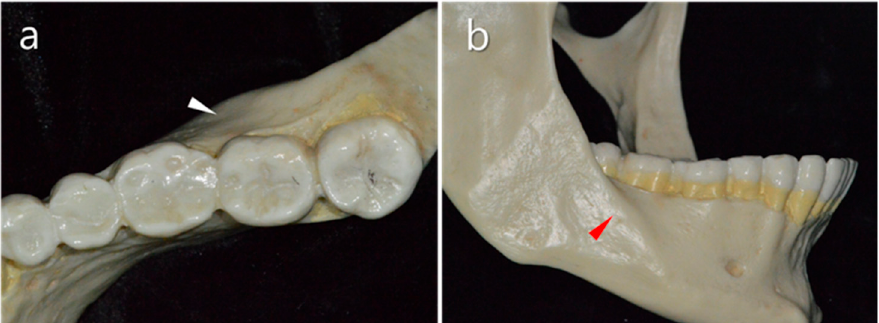
Figure 1. Anatomical features of the mandibular molar area. ( a ) Thick buccal bone of the mandible (white triangle). ( b ) Oblique ridge in the second mandibular molar area (red triangle).